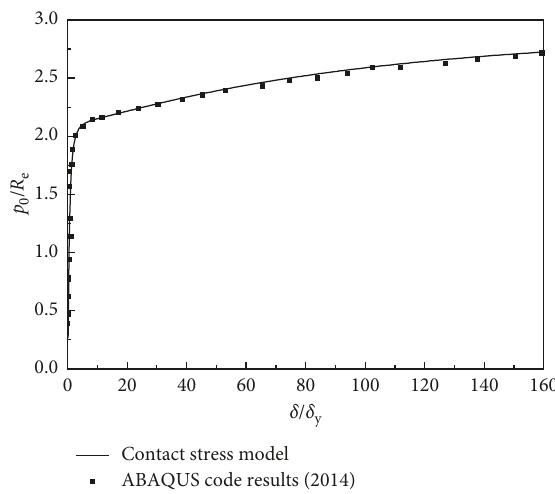
Figure 5: Relation between the contact pressure and the contact deformation.